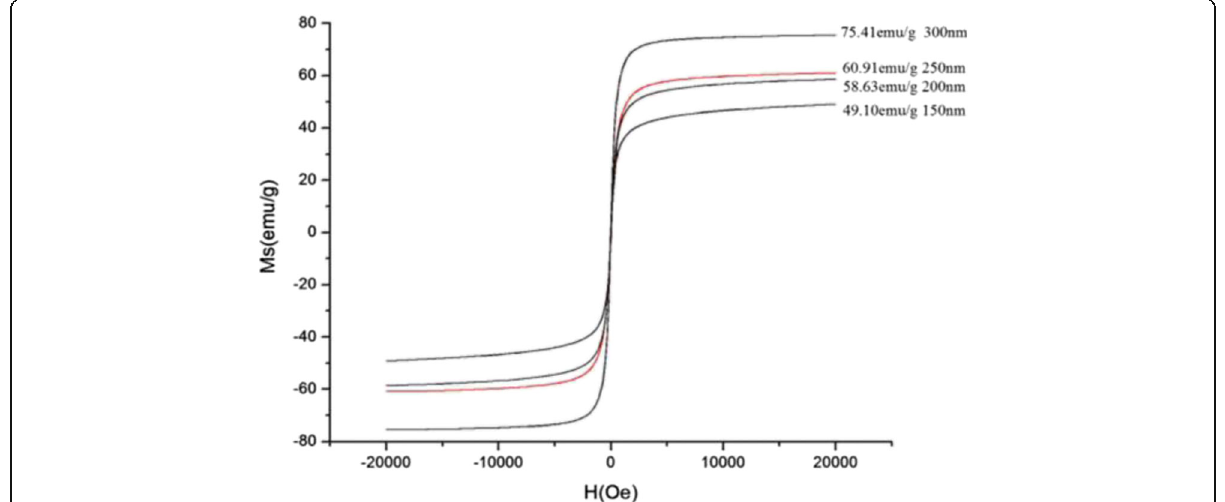
Fig. 11 Room temperature magnetic hysteresis loops of Fe 3 O 4 hollow microspheres at different